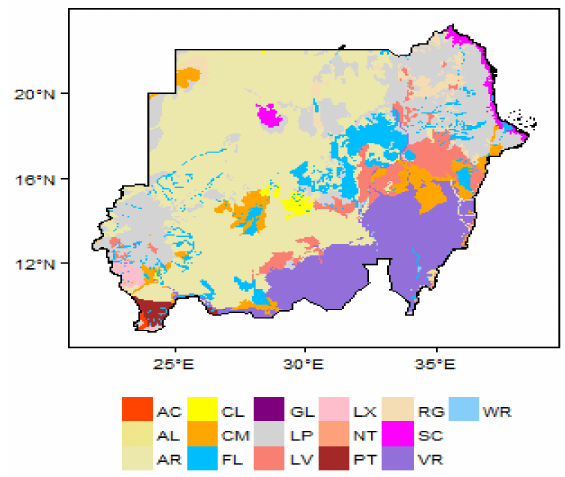
Figure 8. Soil map of Sudan [18]. Acrisols (AC), Alisols (AL), Calcisols (CL), Cambisols (CM), Fluvisols (FL), Gleysols (GL), Arenosols (AR), Leptosols (LP), Lixisols (LX), Luvisols (LV), Plinthosols (PT), Regosols (RG), Solonchaks (SC), Nitisols (NT), Vertisols (VR), Water Body